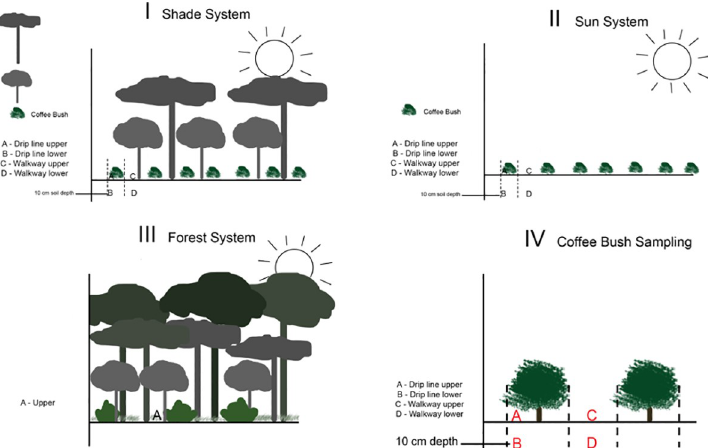
Fig 1. System and bush sampling schematic. I & II. We randomly sampled soil from seven bushes from each of the coffee plantation systems (shade and sun) with four sampling sites per bush. III. We randomly collected 14 soil samples from a nearby forest. IV. Zoomed in view of II: we collected an upper drip line sample, 10 cm depth drip line sample, upper walkway sample, and 10 cm depth walkway sample for each sun and shade coffee